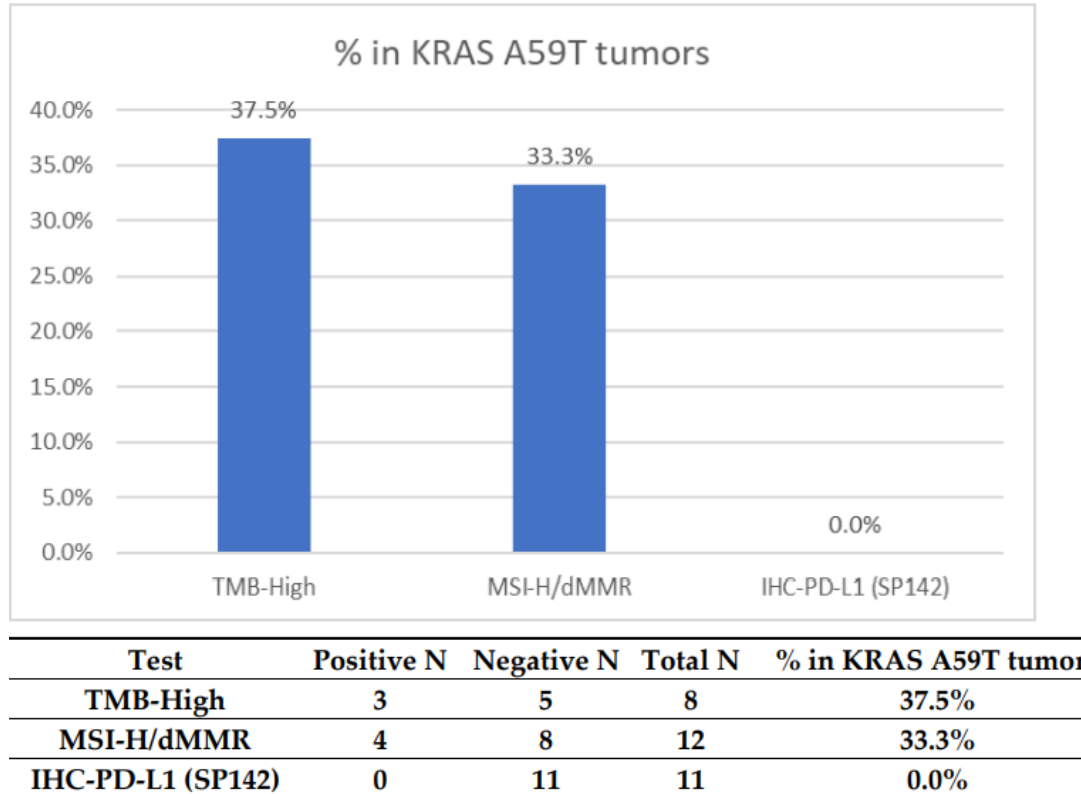
Figure 1. Prevalence of potential predictors for IO markers in KRAS A59T-mutated CRC. The cutoff for TMB high was >17. The cutoff for PD-L1 (SP142) was 2+, 5%.